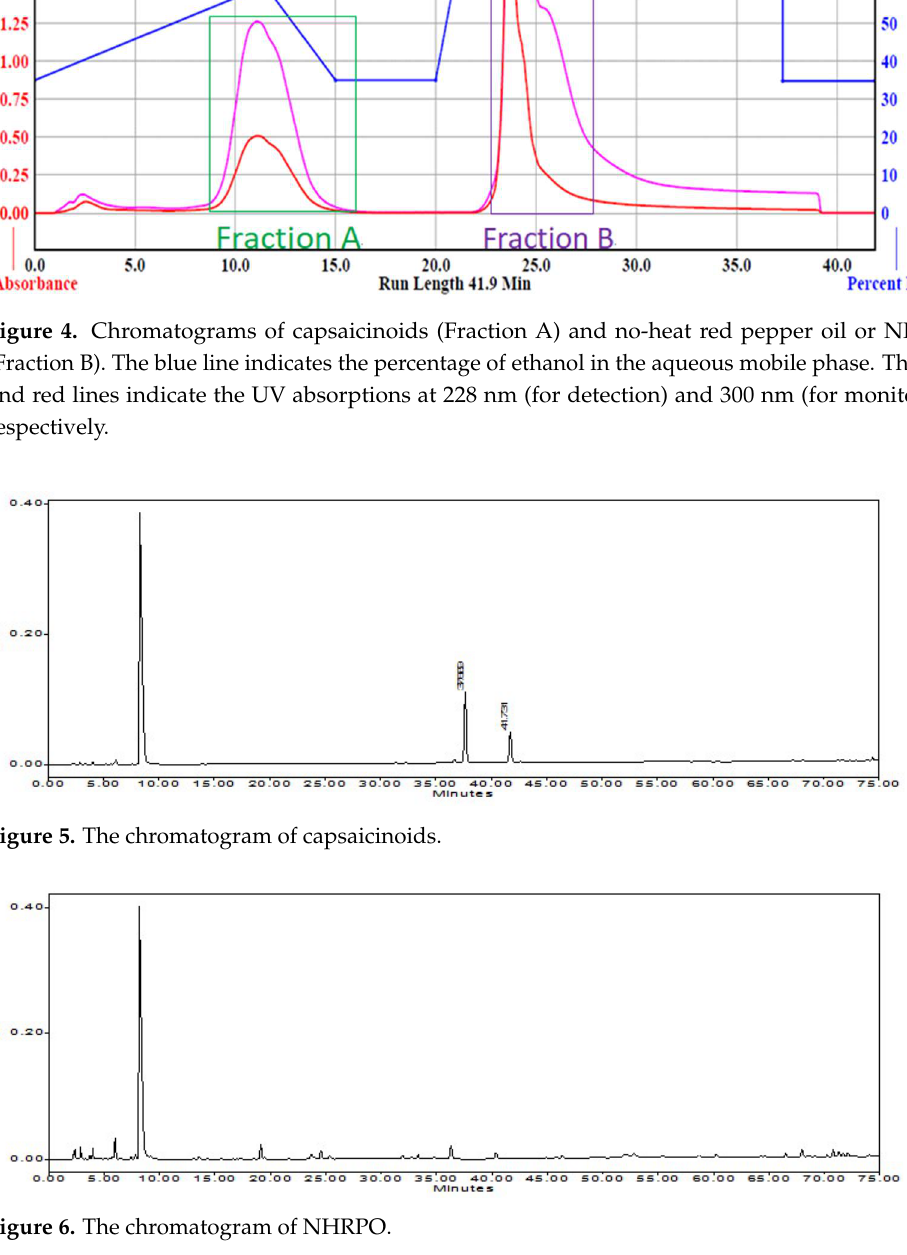
Figure 7. Chromatogram of capsaicins showing the separation of capsaicin (Fraction C) from other capsaicin derivatives. The blue line indicates the percentage of ethanol in the aqueous mobile phase. The pink and red lines indicate the UV absorptions at 228 nm (for detection) and 300 nm (for monitoring), respectively. When all capsaicinoids were processed, 60 g of pure capsaicin was obtained. The purity of isolated capsaicin was 95% based on HPLC analysis (Figure 8). The yield was 50% from the capsaicinoids or 0.4% w / w of the beginning waste material PSW. The un- accounted was assumingly lost during the process. Figure 8. The chromatogram of isolated capsaicin.